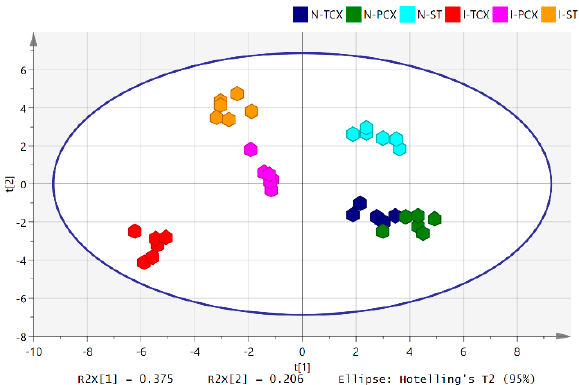
Figure 1. TTC stain of a coronal rat brain section after tissue puncture. The normal brain area at the left hemisphere was stained in red, whereas the ischemic brain area was stained in white. Punctured areas were color-marked in hexagons: blue: normal temporal cortex (N-TCX); green: normal parietal cortex (N-PCX); light blue: normal striatum (N-ST); red: ischemic temporal cortex (I-TCX); pink: ischemic parietal cortex (I-PCX); orange: ischemic striatum (I-ST). Color codings of the specific brain regions in this figure are used throughout. Bar = 1 mm.